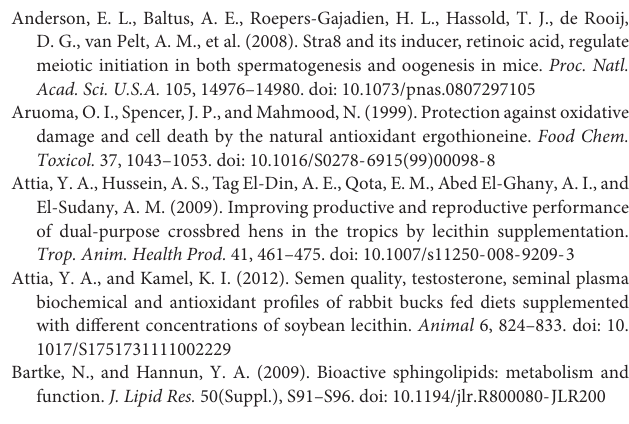
TABLE S4 | Metabolite set enrichment of the differential metabolites of female worms between SCID mice and BALB/c mice. Metabolite sets are enriched of the differential metabolites between female worms from SCID mice and female worms from BALB/c mice. TABLE S5 | Metabolite set enrichment of the common differential metabolites in male and female worms from SCID mice. Metabolite sets are enriched of the common differential metabolites between male worms and female worms from SCID mice compared with those from BALB/c mice. TABLE S6 | Metabolite set enrichment of the male worm-specific differential metabolites between SCID mice and BALB/c mice. Metabolite sets are enriched of the male worm-specific differential metabolites between SCID mice and BALB/c mice. TABLE S7 | Metabolite set enrichment of the female worm-specific differential metabolites of those between SCID mice and BALB/c mice. Metabolite sets are enriched of the female worm-specific differential metabolites between SCID mice and BALB/c mice. TABLE S8 | Pathway analysis of the differential metabolites of male worms between SCID mice and BALB/c mice. This list contains the enriched metabolic pathways of the differential metabolites of male worms between SCID mice and BALB/c mice. TABLE S9 | Pathway analysis of the differential metabolites of female worms between SCID mice and BALB/c mice. This list contains the enriched metabolic pathways of the differential metabolites of female worms between SCID mice and BALB/c mice. TABLE S10 | Pathway analysis of the common differential metabolites in male and female worms from SCID mice. This list contains the enriched metabolic pathways of the common differential metabolites between male worms and female worms from SCID mice compared with those from BALB/c mice. TABLE S11 | Pathway analysis of the male worm-specific differential metabolites between SCID mice and BALB/c mice. This list contains the enriched metabolic pathways of the male worm-specific differential metabolites between SCID mice and BALB/c mice. TABLE S12 | Pathway analysis of the female worm-specific differential metabolites between SCID mice and BALB/c mice. This list contains the enriched metabolic pathways of the female worm-specific differential metabolites between SCID mice and BALB/c mice. TABLE S13 | Information of qPCR primers of the tested genes 1 involved in retinol metabolism and meiosis. This list contains the detailed information of